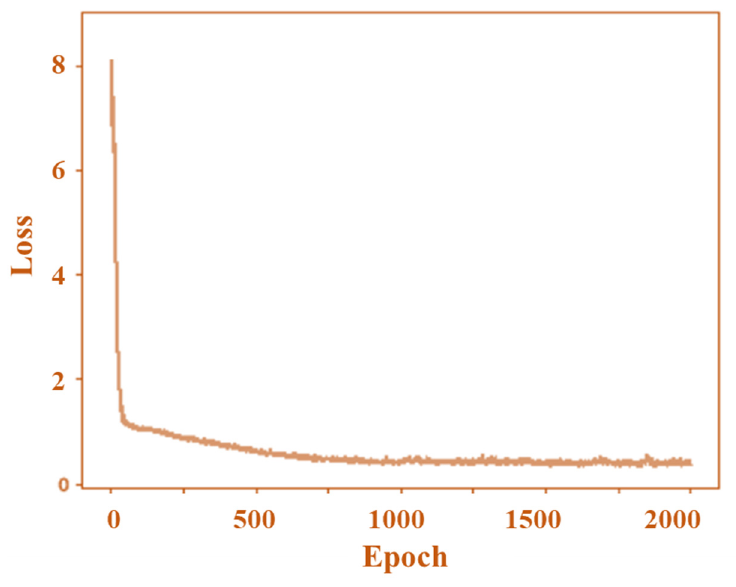
Table 1. Diagnosis results for basic scratch fault.